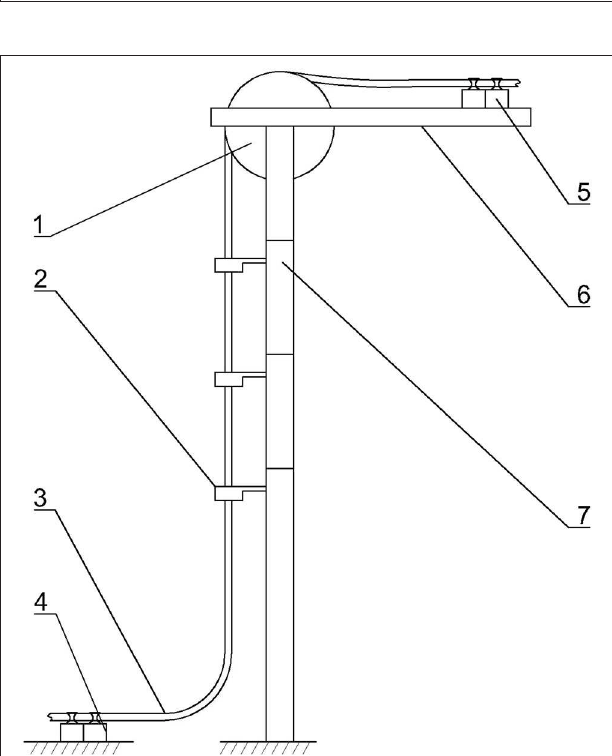
FIGURE 7 | Cable delivery mechanism (1: reel, 2: fairleads, 3: cable, 4: the below cable delivery device, 5: the above cable delivery device, 6: top platform, 7: guide